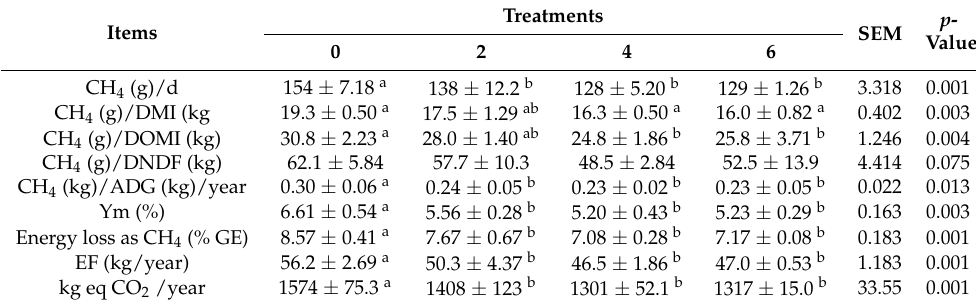
Table 7. Effect of palm oil supplementation on enteric methane emissions in